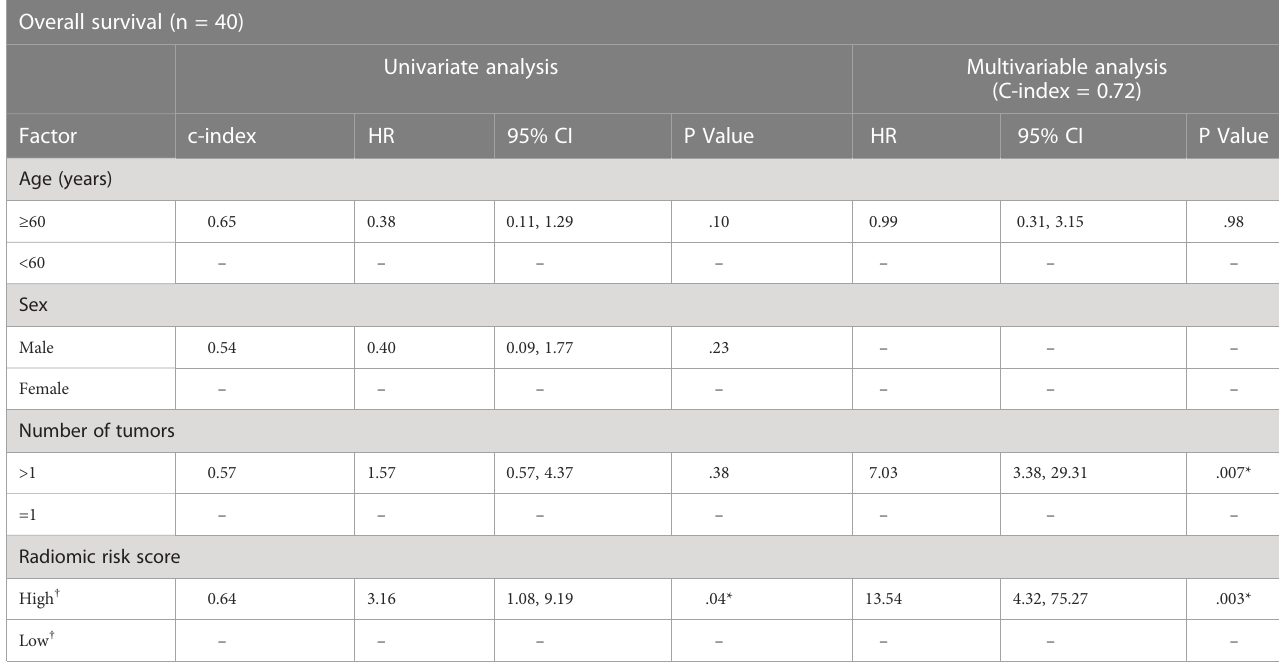
c-index, concordance index; HR, hazard ratio; CI, con fi dence interval. *with p value that indicates statistical signi fi cance. -denotes reference groups. † high and low risk groups are determined using the default threshold for logistic regression models